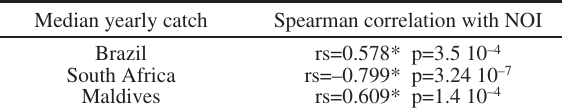
Table 2. – Spearman correlation coefficient calculated between median yearly catch (t) and NOI. The asterisk indicates significant correlation.